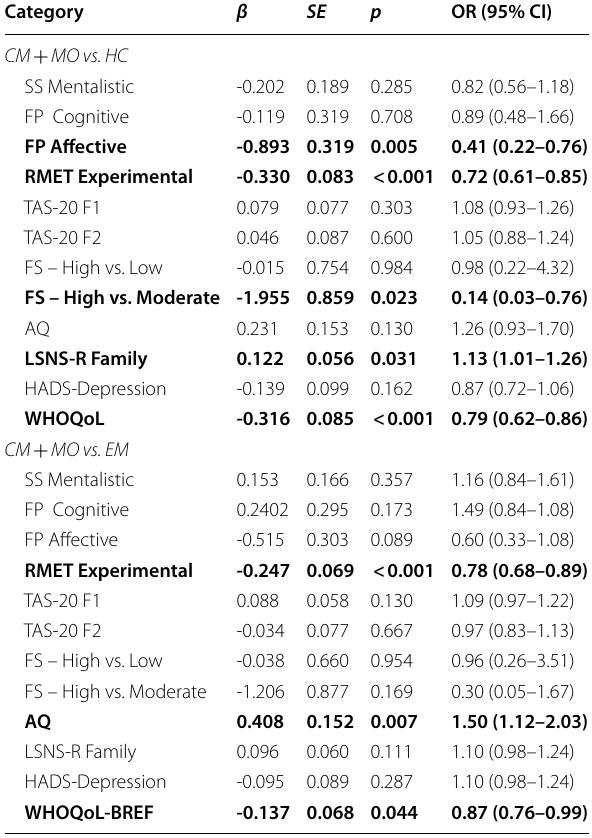
Table 5 Regression coefficients (β) and odds (OR) and 95% CI Corresponding to the Binary Logistic Regression